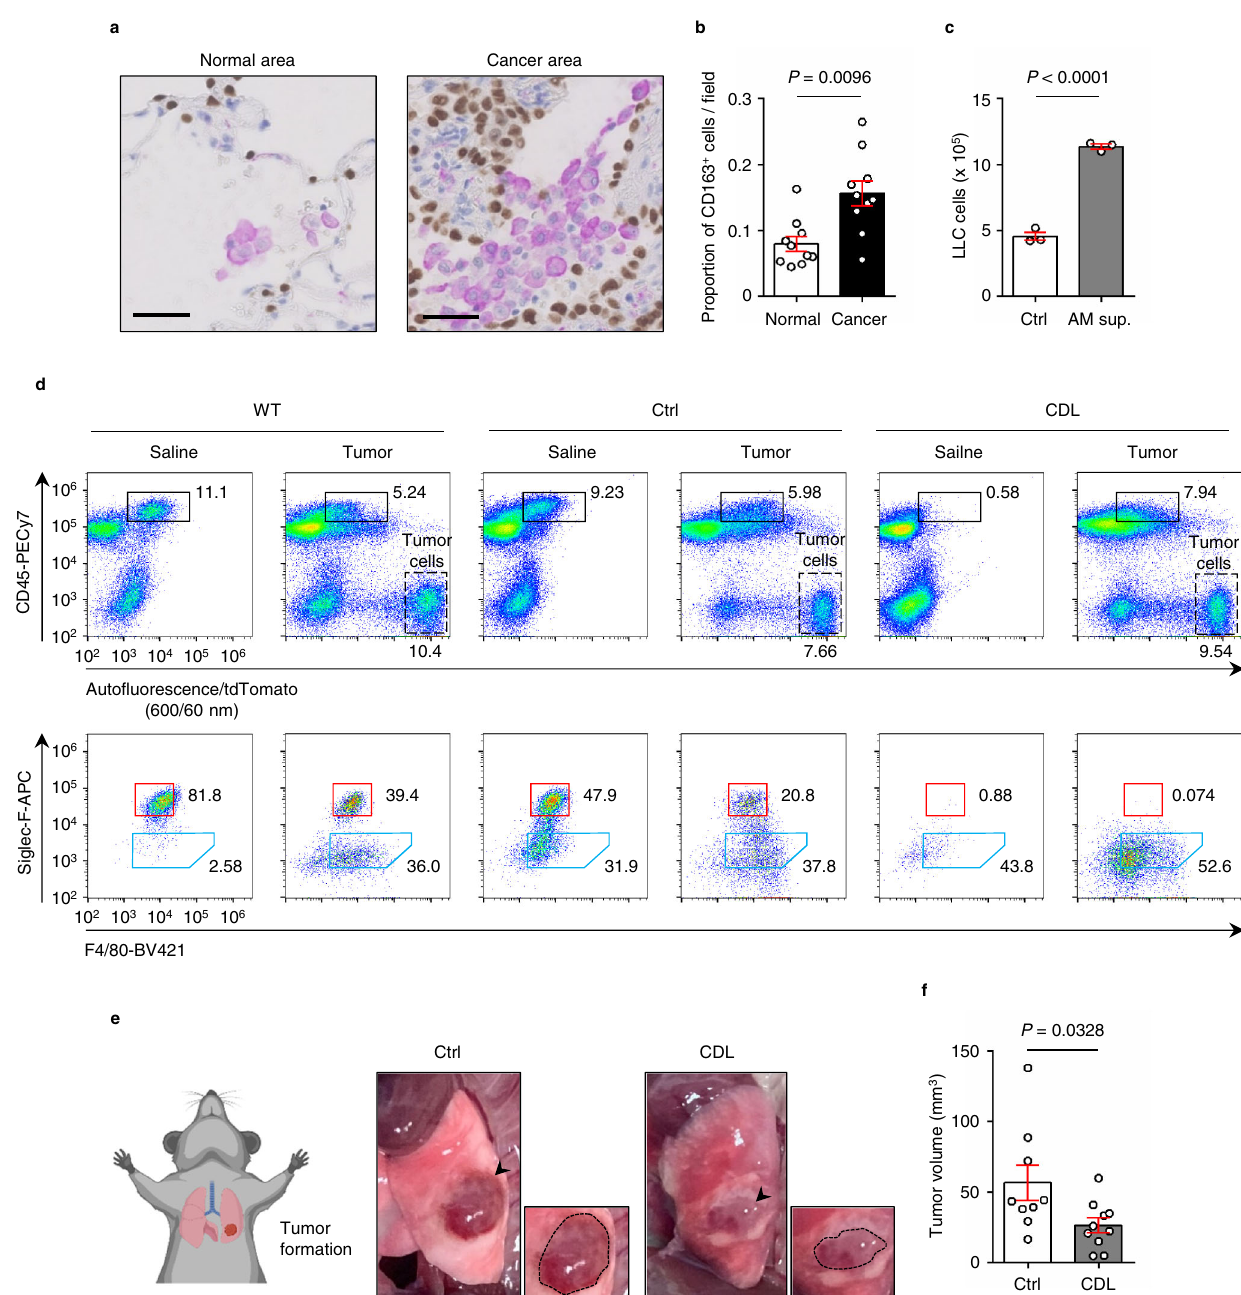
Fig. 1 | Lung alveolar macrophages (AMs) support proliferation of lung cancer cells.a Representativeimagesofimmunohistochemicalstainingofthenormallung area ( left ) and lung cancer area ( right ) from patients with lung cancer. Patient information is listed in Supplementary Table 1. Purple cells indicate CD163 + mac- rophages and brown nuclei indicate alveolar epithelial cells or carcinoma cells positive for thyroid transcription factor-1 (TTF-1). Scale bars; 50 μ m. b Proportion of CD163 + macrophagesintotalcellswithinthevisual fi eldinnormallungand lung cancer areas, calculated from the mean value of four different visual fi elds ( n =10 patients). c Cell count assay. LLC cells were seeded, starved for 24h, and cultured for2dayswith(orwithout)AMcellsupernatant( n =3pergroup). d Flowcytometry plotsoflungcellsfromwild-type(WT)C57BL/6mice,control-liposome(Ctrl)mice, and clodronate liposome (CDL)-treated mice, with or without tumor-bearing con- ditions. LLC cells was fl uorescently labeled with tdTomato (region with a dashed